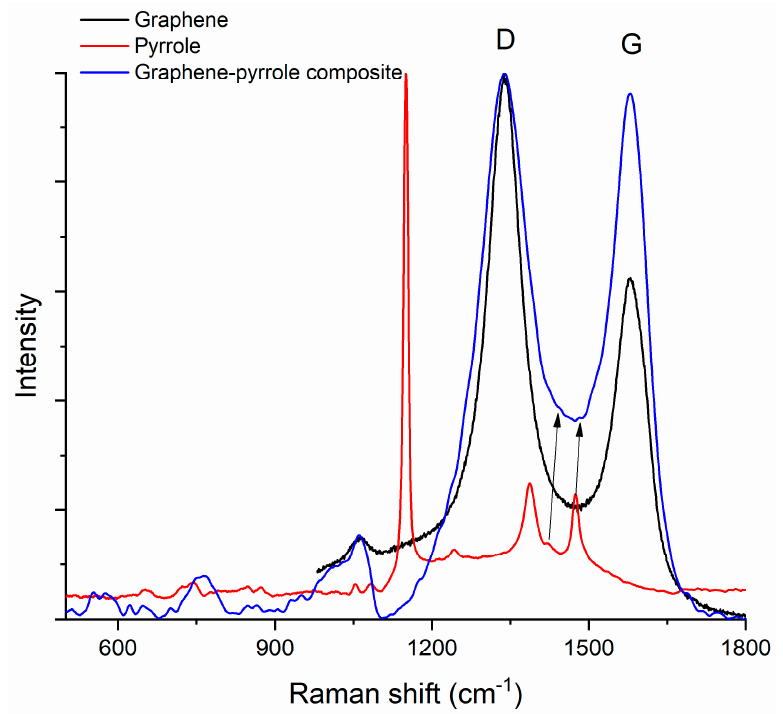
Figure 4. Raman spectrum of the composite compared to the Raman spectra of the constituents. The arrows indicate the low intensity peaks at 1386 and 1476 cm − 1 associated with pyrrole.